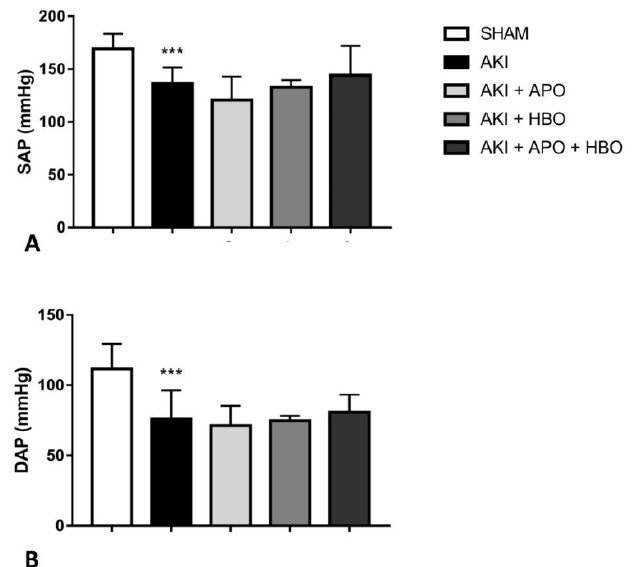
Figure 2. Systemic hemodynamic parameters 24 h after reperfusion; SAP—systolic arterial pressure ( A ), DAP—diastolic arterial pressure ( B ); SHAM—sham-operated rats; AKI—rats with induced postischemic acute kidney injury; AKI + APO—animals with acute kidney injury and apocynin treatment; AKI + HBO—group exposed to HBO preconditioning before acute kidney injury induction; AKI + APO + HBO—animals exposed to HBO preconditioning before and treated with apocynin after acute kidney injury induction. Student’s t -test for independent samples (SHAM vs. AKI), one–way ANOVA with Dunnett’s multiple comparisons post hoc test (AKI vs. AKI + APO, AKI + HBO, AKI + APO + HBO); *** p < 0.001 vs. SHAM